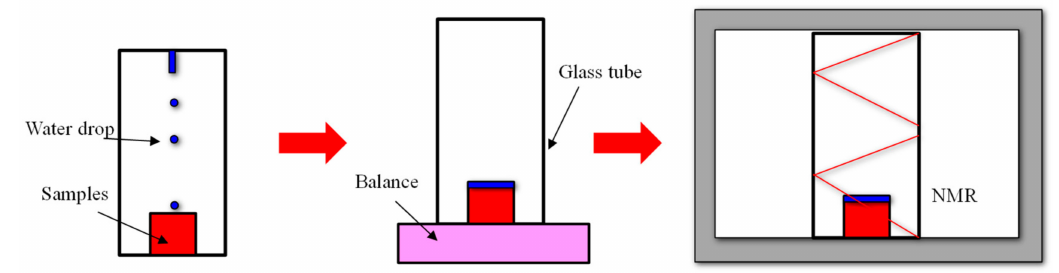
Figure 2. Schematic of imbibition procedure in hydrate sediment samples.